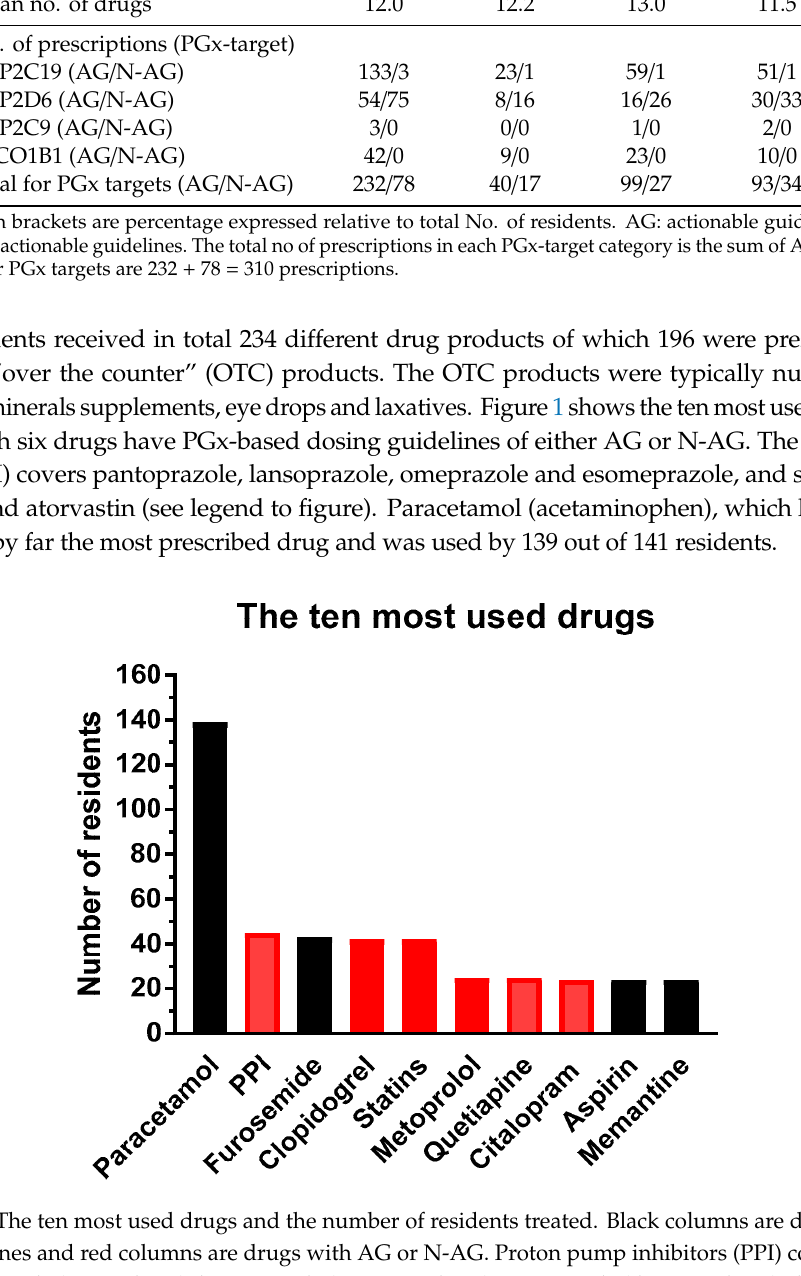
Table 1. Demographic characteristics, drug use and number of prescriptions for pharmacogenomics (PGx) targets.